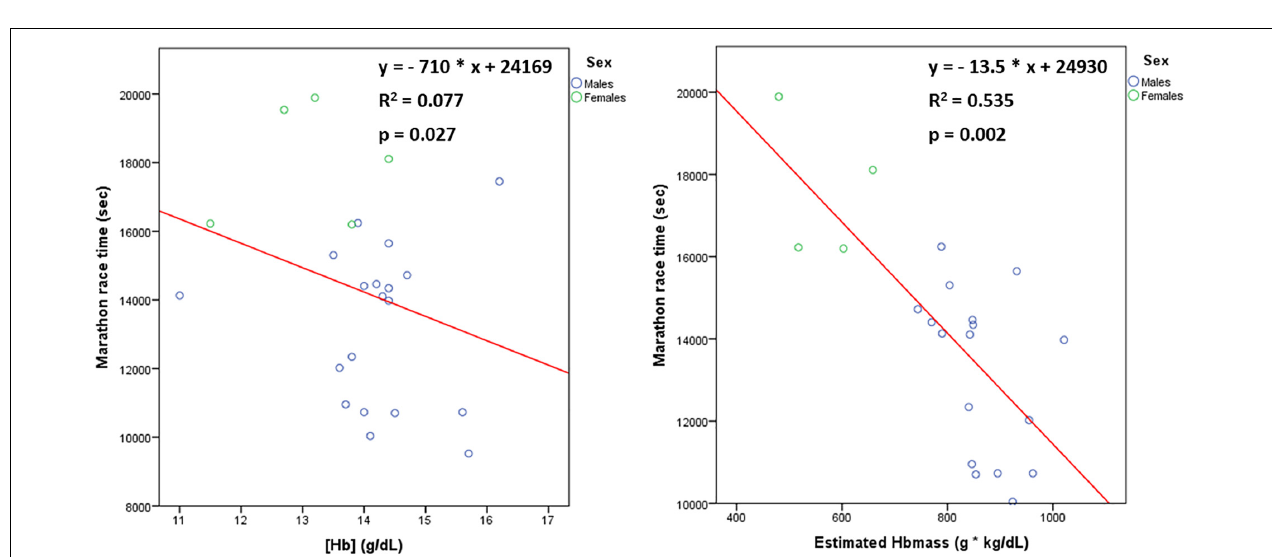
FIGURE 5 | The relationship [ n = 24 (19 males, 5 females)] of marathon race time with haemoglobin concentration ([Hb]) and estimated haemoglobin mass (Hbmass).